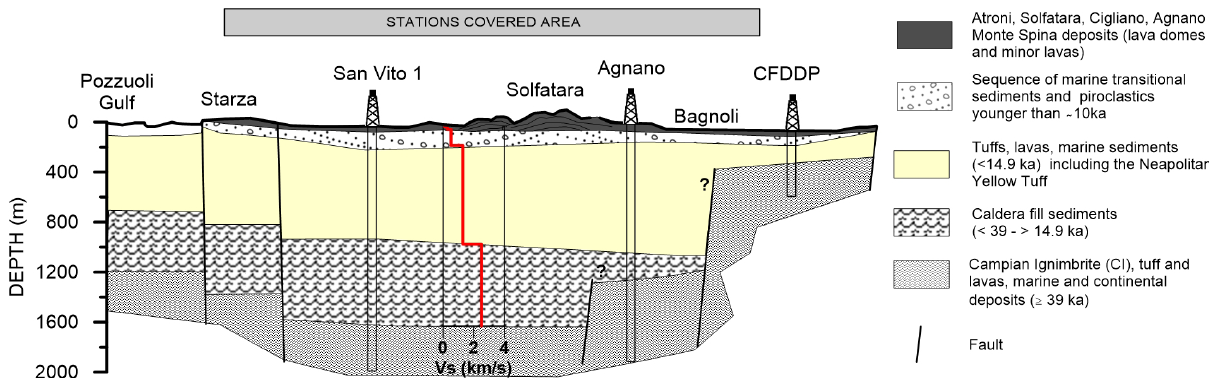
Figure 10. Large scale geological interpretation modified after Piochi et al. (2014), along the blue dotted line reported in Fig. 1. The contact between the principal lithological sequences are inferred from the stratigraphic information of the deep drills. The best model obtained from the joint inversion (Fig. 8 and Table 2) is reported with the red